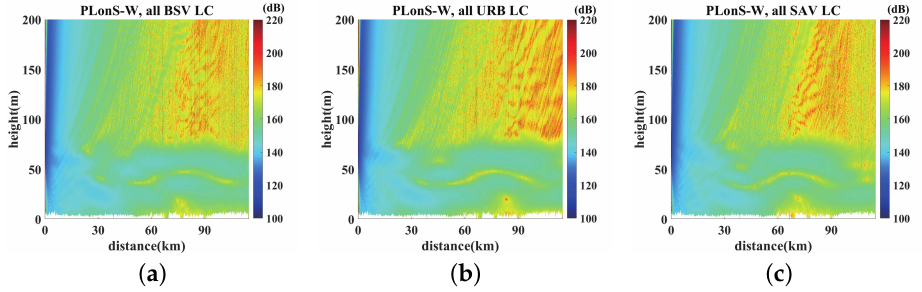
Figure 19. The PL using the improved TWPE with ( a ) BSV, ( b ) URB, ( c ) SAV LC, on Shanghai–Wuxi.